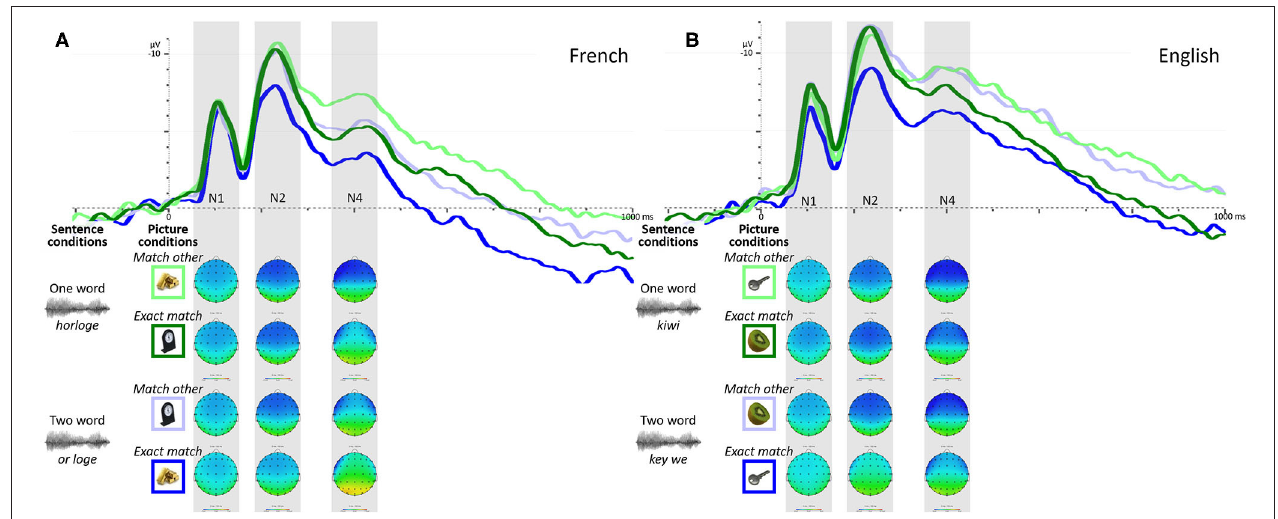
FIGURE 1 | Grand average ERPs over frontal ROI to each sentence and picture condition combination for French (A) and English (B) trials, along with topographic representation over time-windows used for ERP quantification (shadowed boxes). Green waveforms represent ERPs to the one word condition while blue waveforms represent the two word condition; darker colors represent the “exact match” picture condition while the lighter colors represent the “match other” condition.